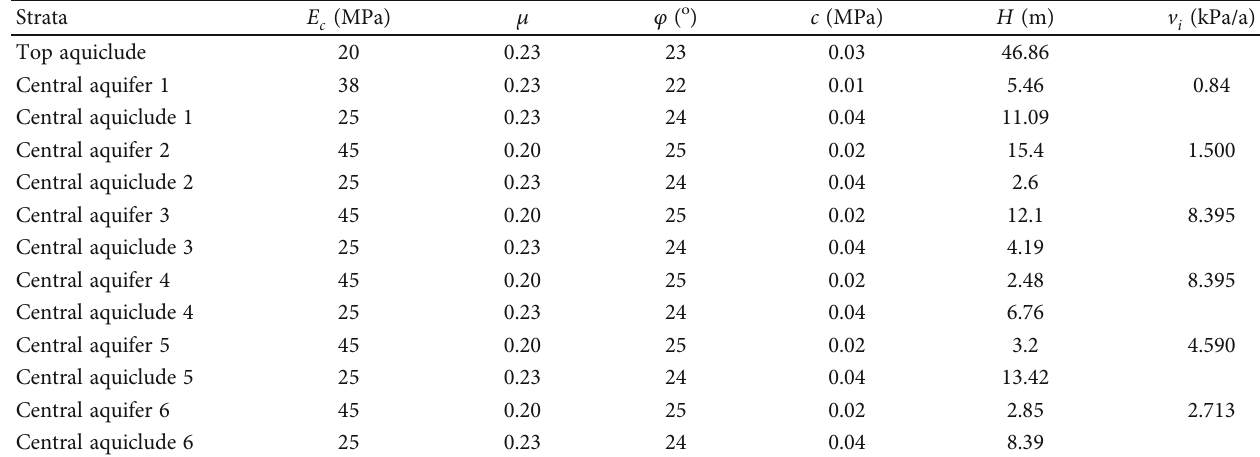
Figure 9: Simpli fi ed geological model around the west ventilation shaft. Table 1: The parameters of the strata surrounding the west ventilation